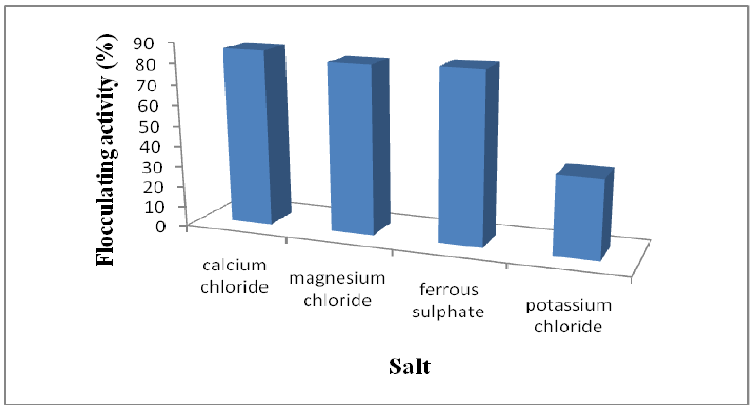
Figure 5. Effect of cations on bioflocculant activity by Halomonas sp. OKOH.